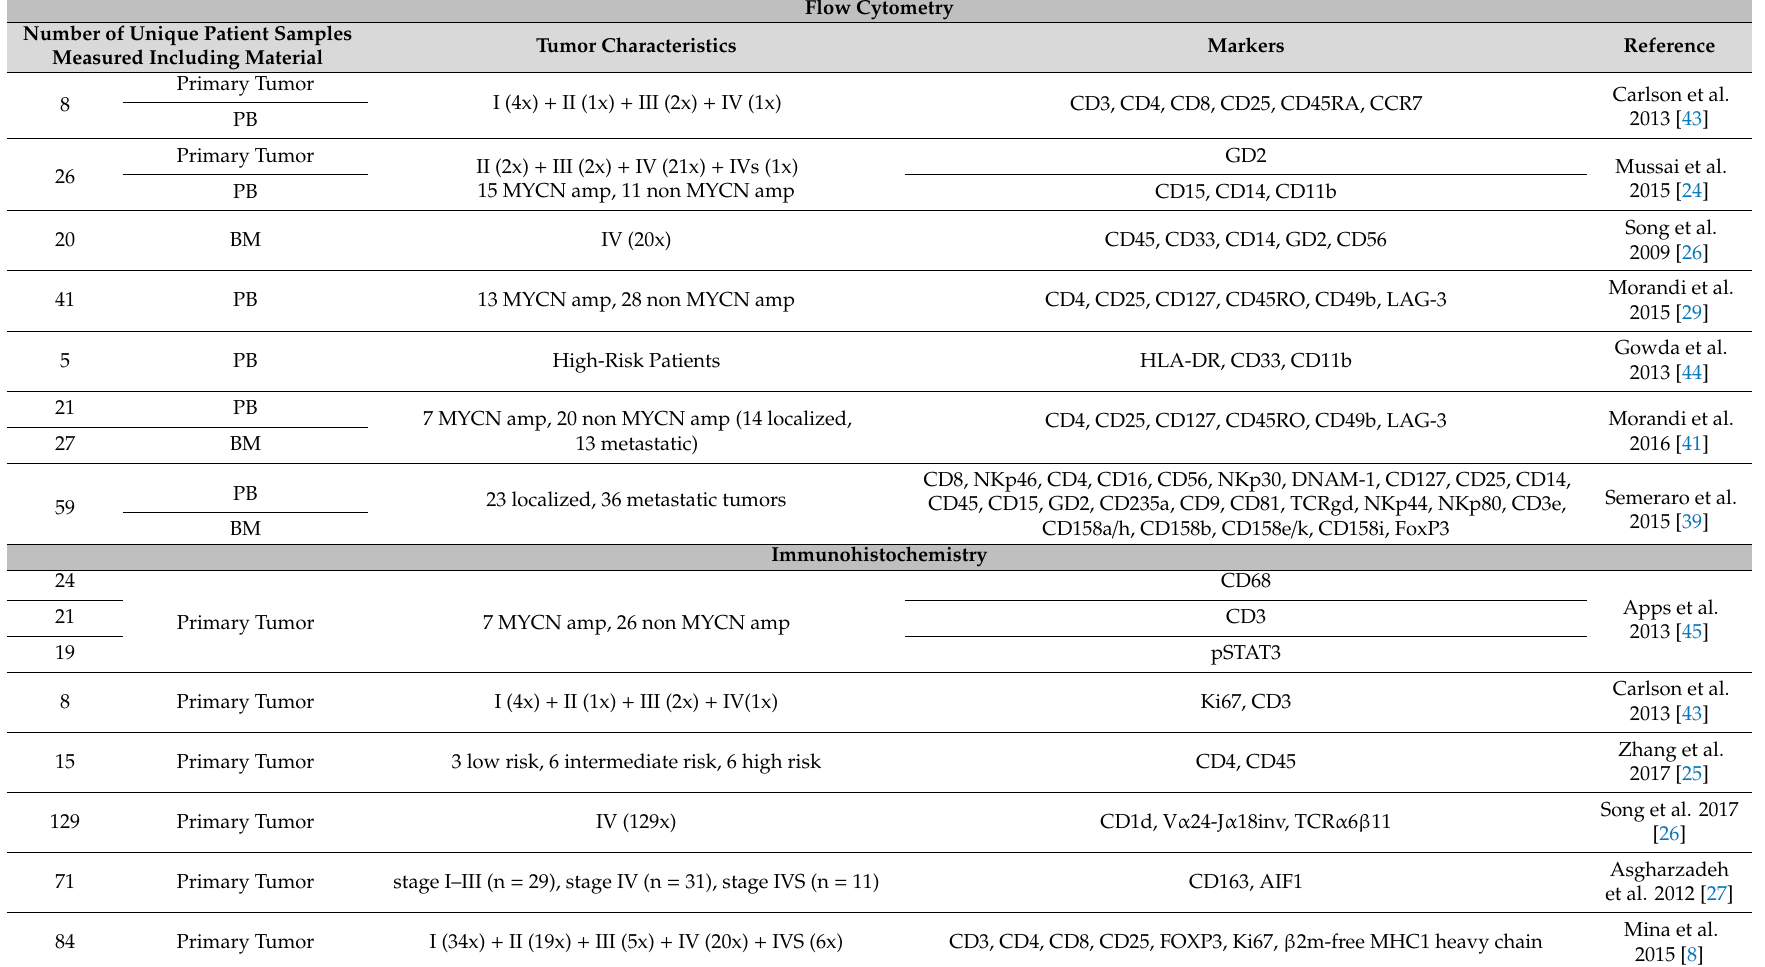
Table 1. Overview of neuroblastoma immune monitoring studies at